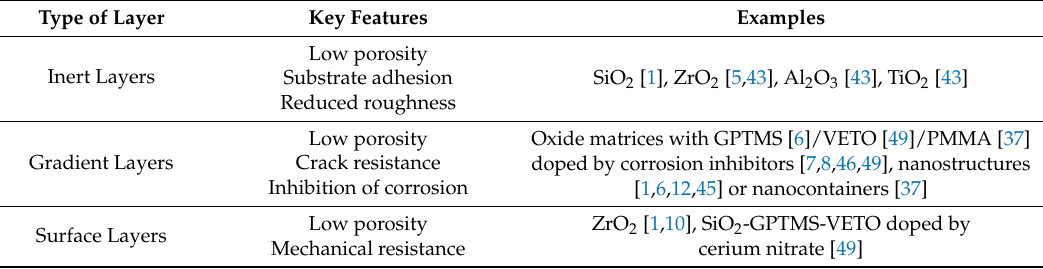
Table 2. A summary of the types of coating